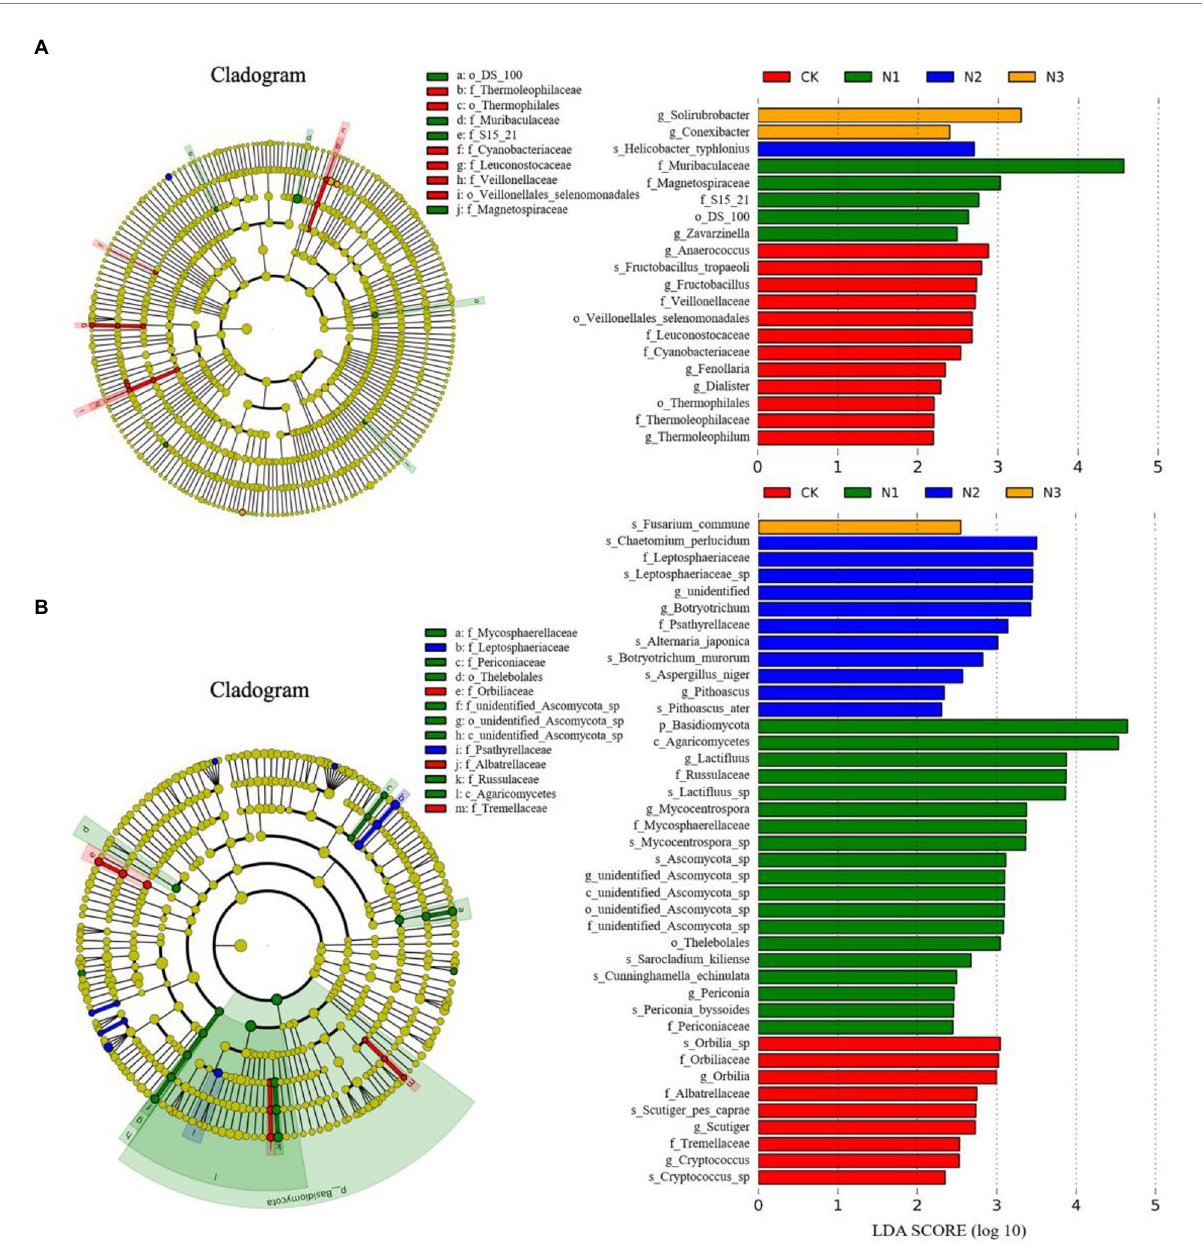
FIGURE 4 The LEfSe analysis of the soil microbial community structure regarding N addition (phylum-genus levels). (A) The LEfSe analysis of the bacterial community